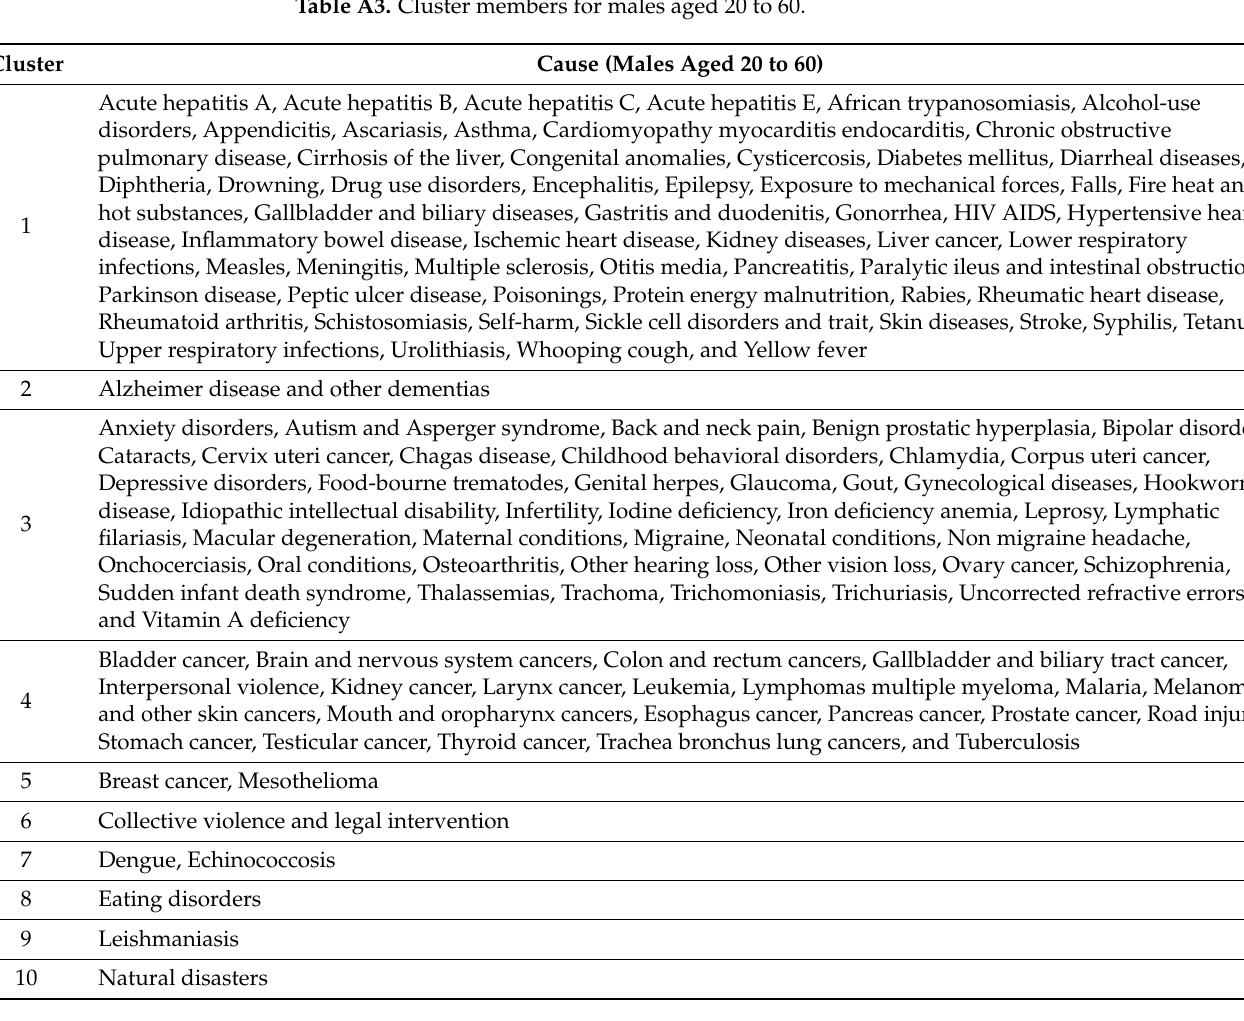
Table A3. Cluster members for males aged 20 to